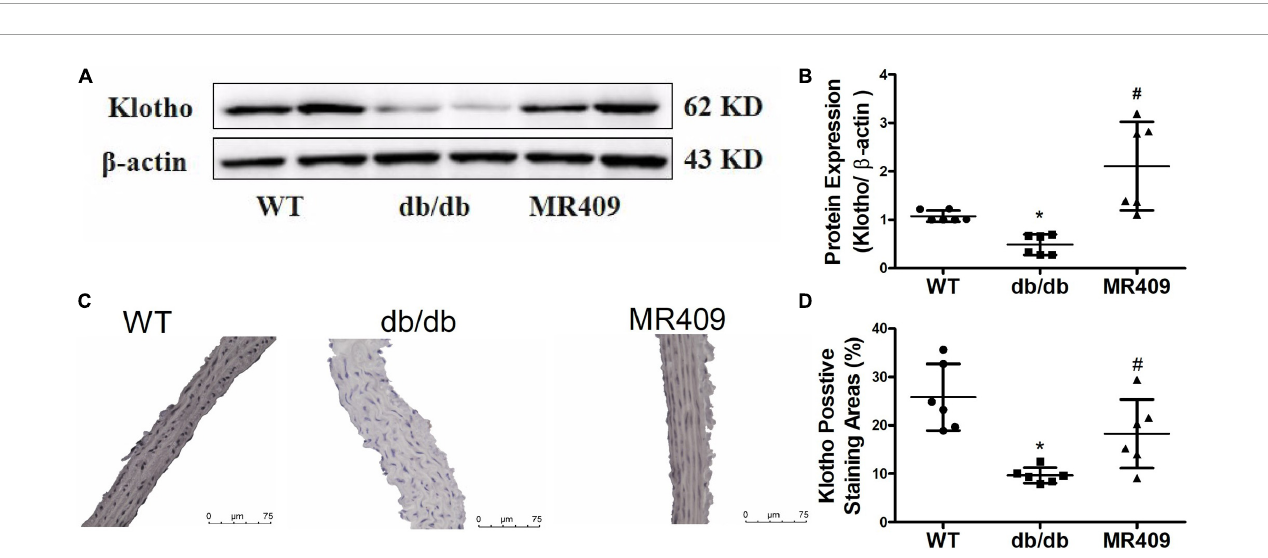
FIGURE7 Treatment with MR409 upregulates the expression of Klotho in the aorta of diabetic db/de mice. The protein expression of Klotho was determined by Western blot (A) , the representative images of Klotho protein expression, determined by immunohistochemistry (C) , the quantitation of Klotho protein expression with Western blot (B) and immunohistochemistry (D) . N = 6, * p < 0.05 diabetic mice vs. WT mice, # p < 0.05 MR409 treated mice vs. diabetic mice.